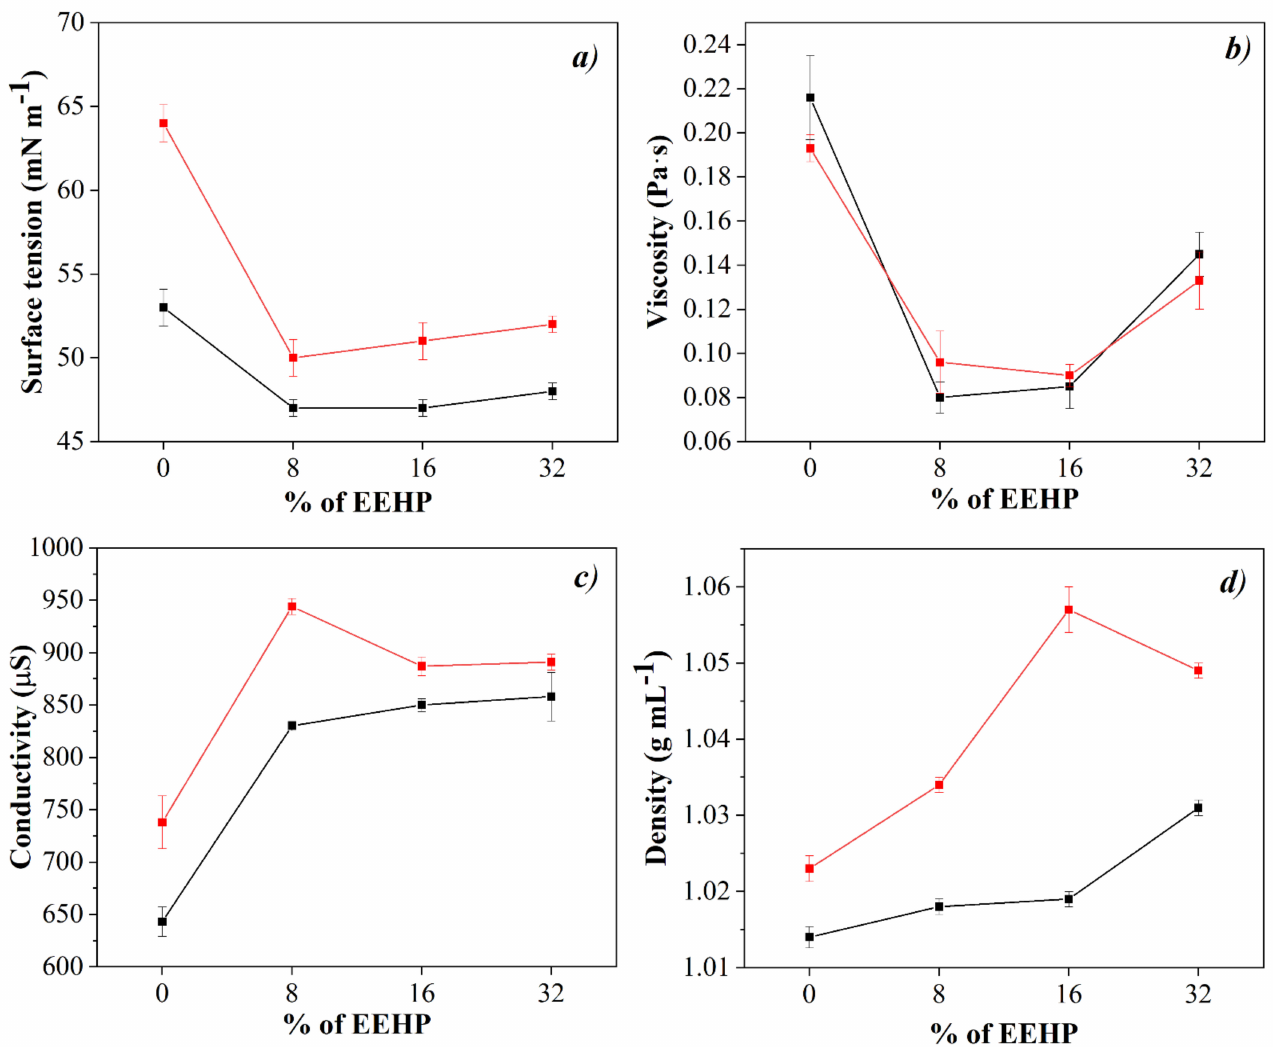
Figure 2. Physicochemical properties of the PVA and PVA/HC solutions added with different concentrations of EEHP. Black line, solutions without HC (6-0-0, 6-0-8, 6-0-16, and 6-0-32), and in red line, solutions with HC (6-5-0, 6-5-8, 6-5-16, and